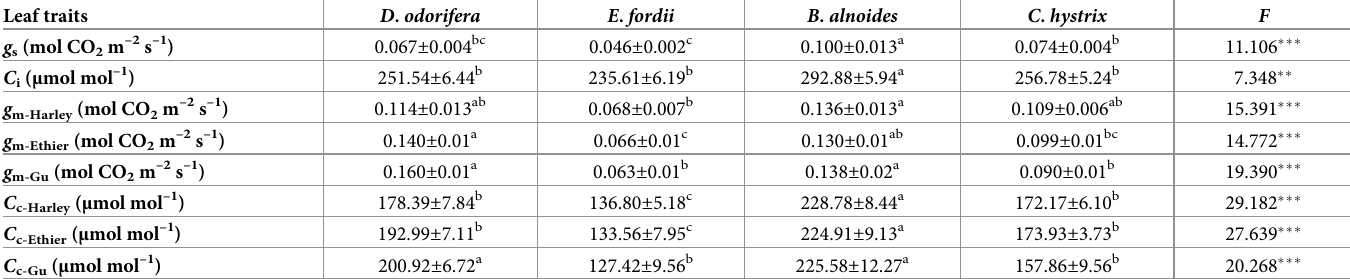
Table 4. Stomatal conductance ( g s ), mesophyll conductance ( g m ), intercellular CO 2 concentration ( C i ), and CO 2 concentration at carboxylation site ( C c ) in four spe- cies seedling leaves. Leaf traits